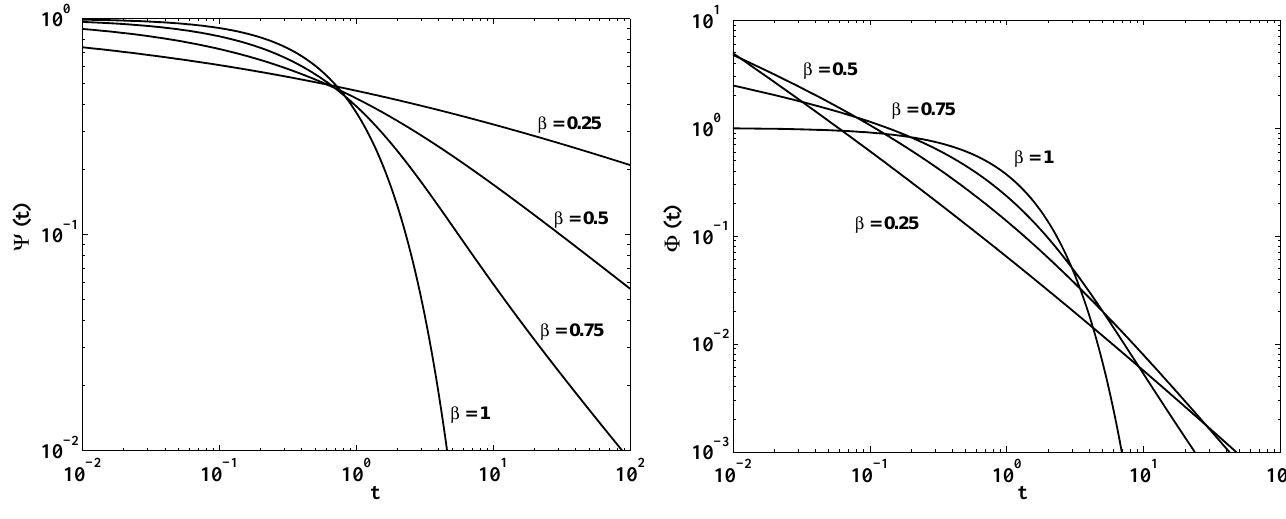
Figure 1. The functions Ψ( t ) ( left ) and φ ( t ) ( right ) versus t ( 10 − 2 < t < 10 2 ) for the renewal processes of Mittag-Leffler type with β = 0 . 25 , 0 . 50 , 0 . 75 , 1